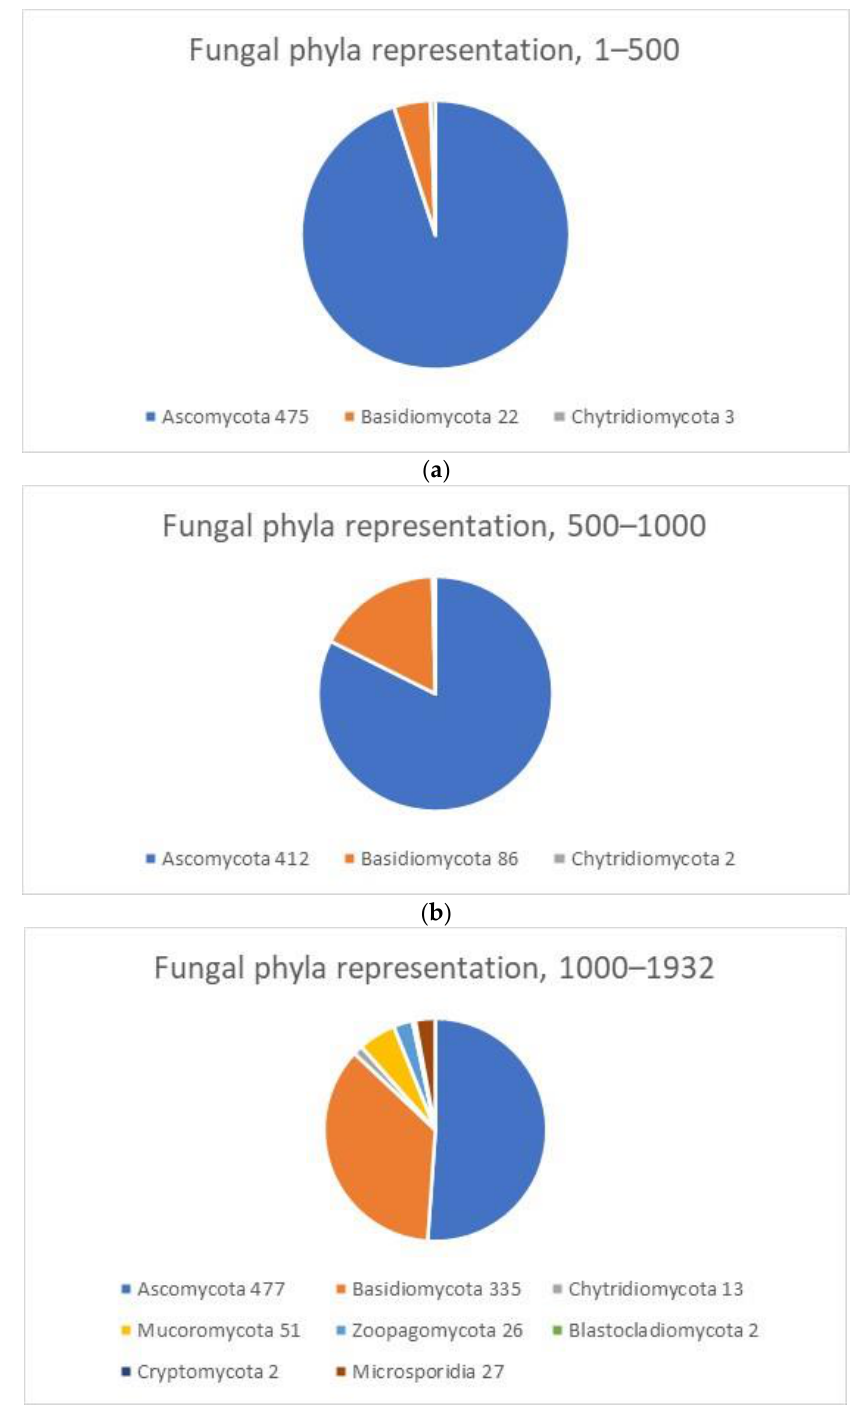
Figure 3. Pie chart representation of representation (in number of species) of fungal phyla in the upper most part of the list of Total biomass-degrading capacity: ( a ): 1–500, ( b ): 500–1000 and ( c ): 1000–1932. Ascomycota species dominates from 1–1000; Basidiomycota grow from 22 to 86 to 335 from upper part to lower part of the ranking list. All 8 fungal phyla are represented in the second half of the ranked listing of in all 1932 species, although some are in such low numbers that values are not visible in the charts, so numbers have been added with the phylum name. Sequencing projects are still biased towards over-representation of Ascomycota and under-representation of especially Chytridiomycota, and